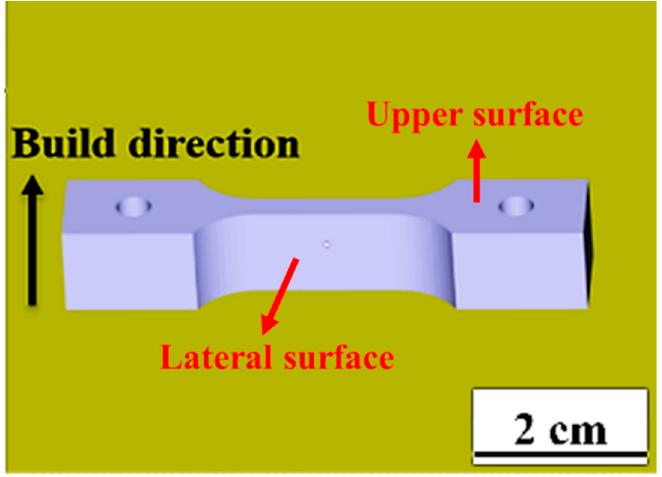
Figure 1. The CAD model is the tensile test specimen with a gage section of 16 mm in length, 3.2